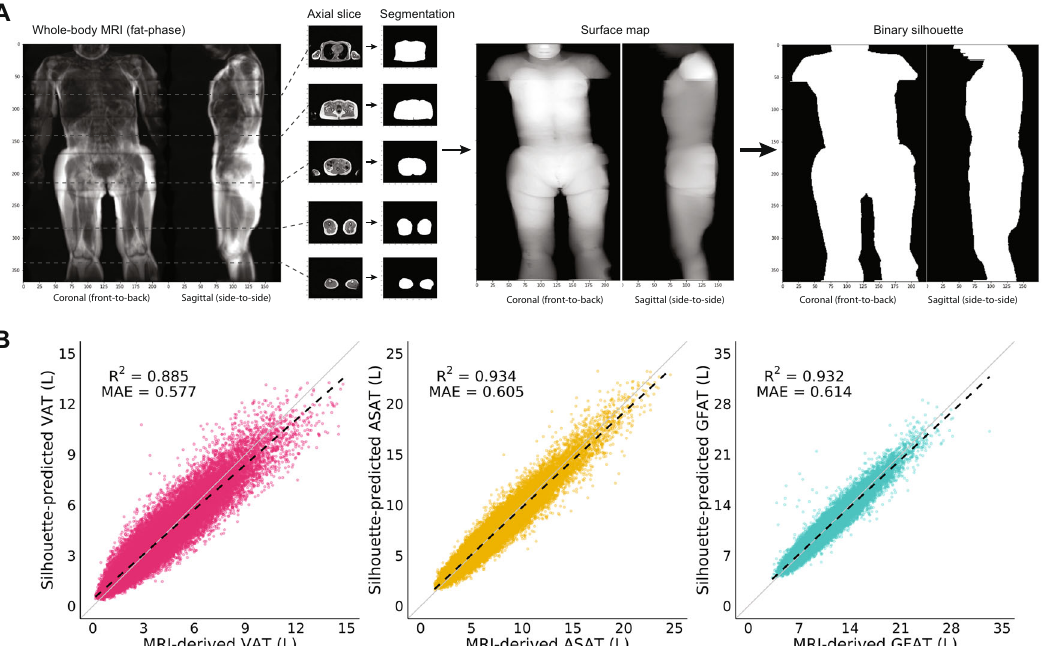
Fig. 1 Silhouettes enable estimation of fat depot volumes. A Silhouettes were created from body MRIs by segmenting the outline of axial acquisitions, projecting the resulting volume onto a two-dimensional surface map, and binarizing pixels. B Silhouette-predicted VAT, ASAT, and GFAT plotted against MRI-derived measurements 14 . Solid black lines denote the linear fi ts, while the solid gray lines correspond to the identity line. Sex-strati fi ed performance metrics and Bland-Altman plots are available in Supplementary Data 1 and Supplementary Figs. 2 –